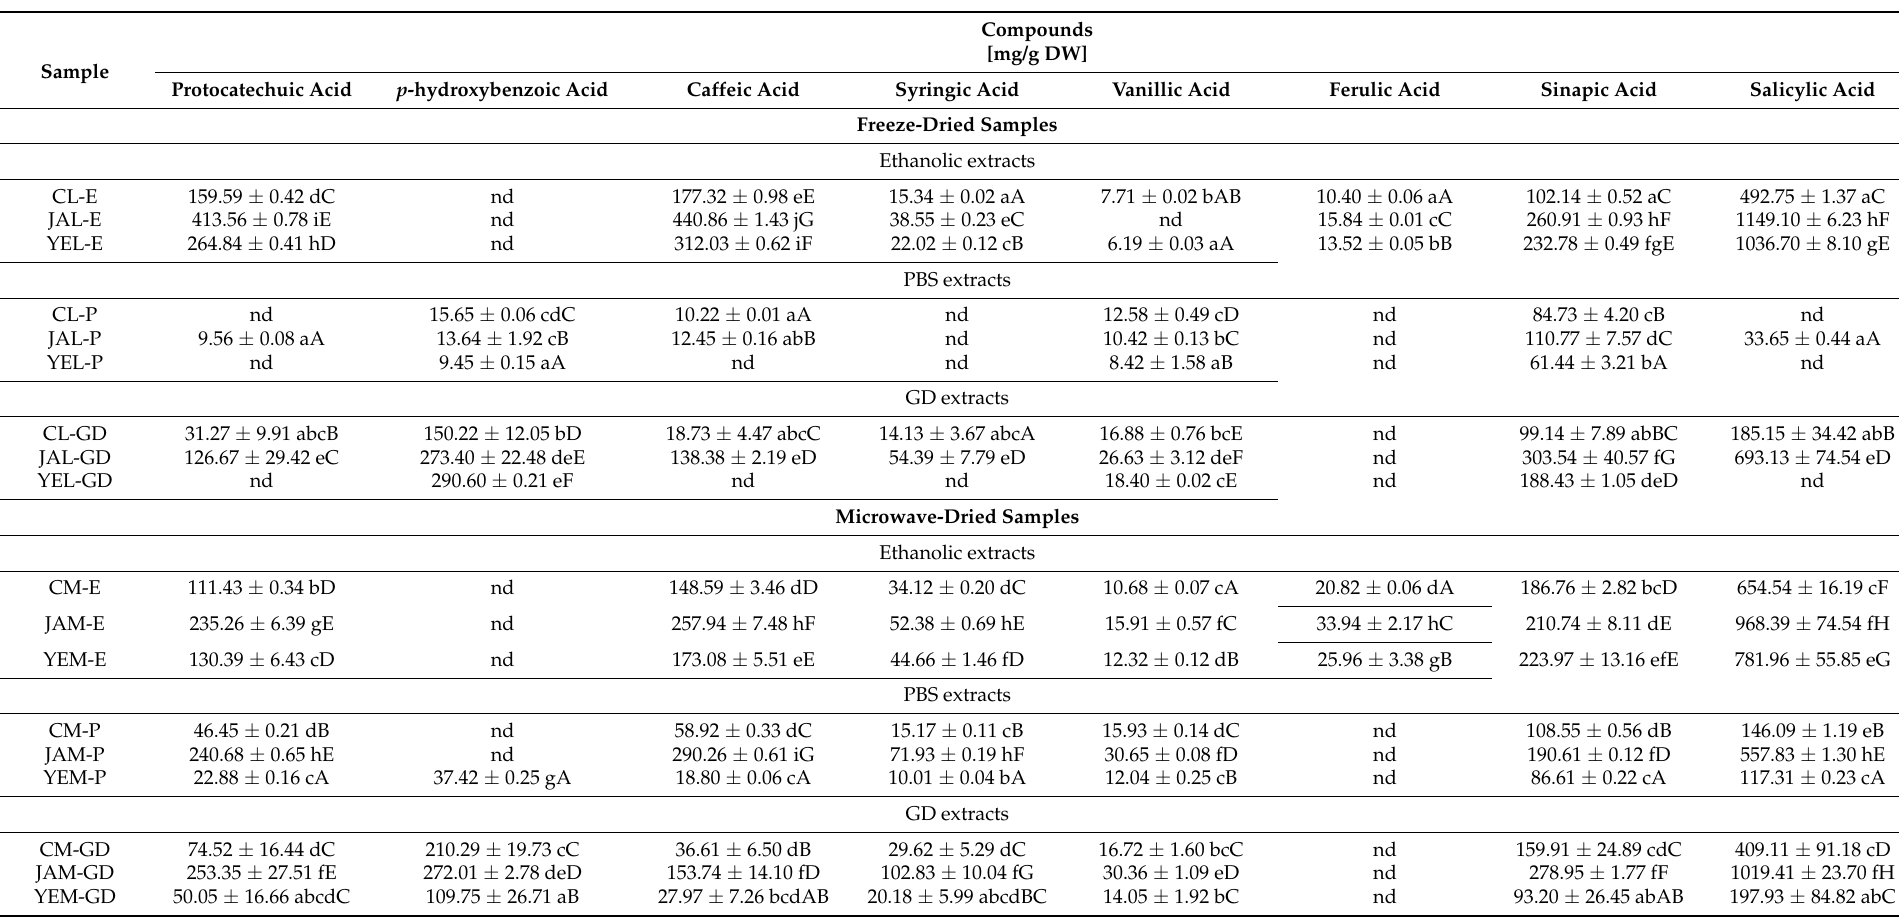
Table 1. Qualitative and quantitative analysis of phenolic acids in the ethanolic, buffer (PBS (phosphate buffered saline)), and gastrointestinally digested (GD) extracts from control and elicited dried lovage